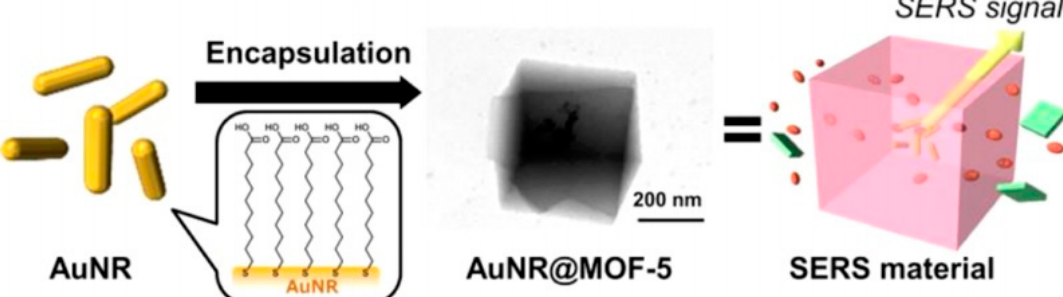
Figure 4. Schematic representation of Au-nanorodes@MOF-5 preparation and SERS activity. Reprinted from [106]. Copyright (2020) American Chemical Society.